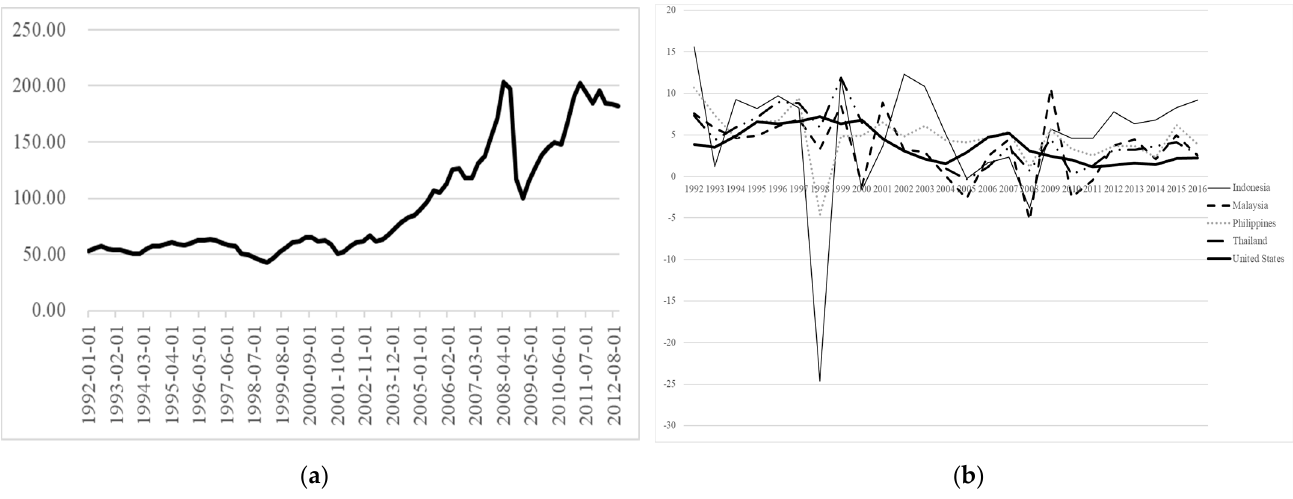
Figure 5. ( a ) International Commodity Composite Index, sourced by the Federal Reserve Bank of St.Louis (2005 = 100); ( b ) Real Interest Rates (Unit: %), sourced by WDI.